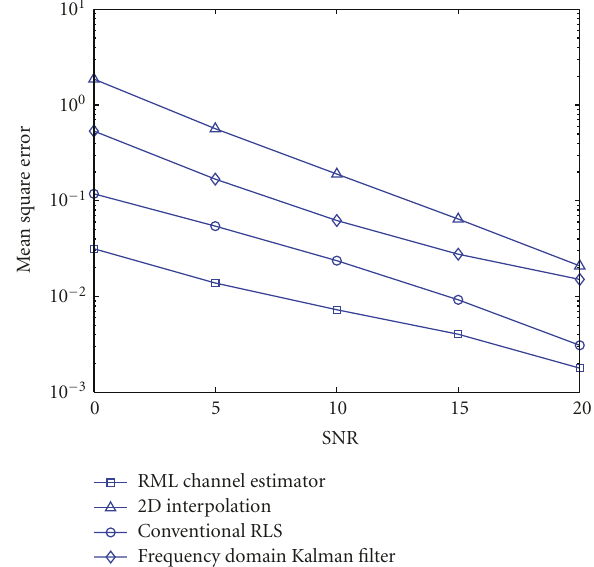
Figure 4: MSE of di ff erent channel-tracking methods as v = 10km/hr ( f d T = 0 . 0086) in urban area.